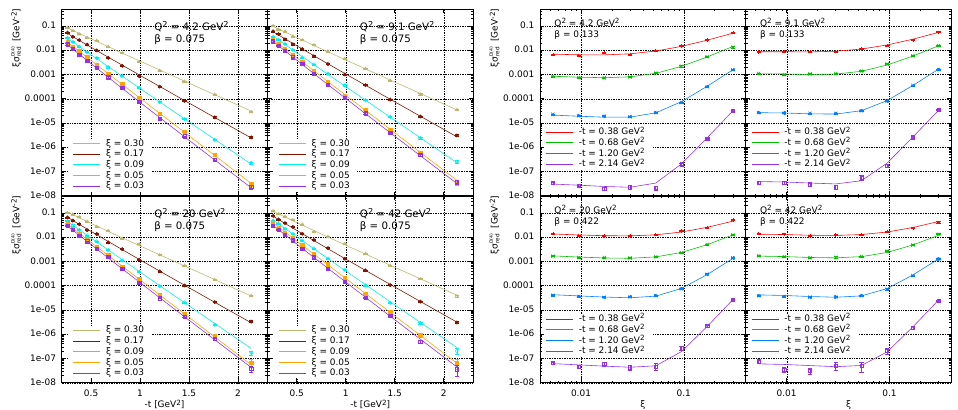
Figure 7: σ D ( 4 ) dependence on t and ξ in selected ( Q 2 , β ) r